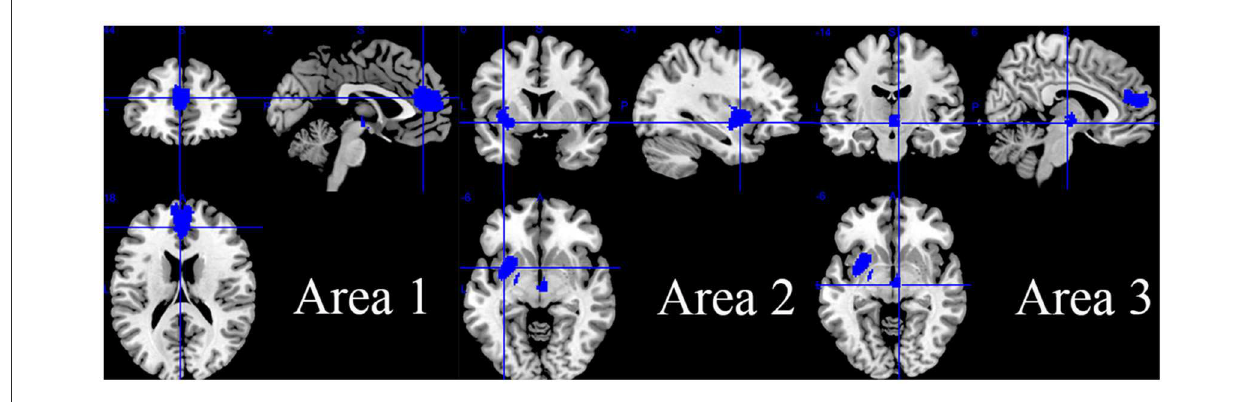
FIGURE3 Regions of decreased intrinsic resting-state brain activity in patients with